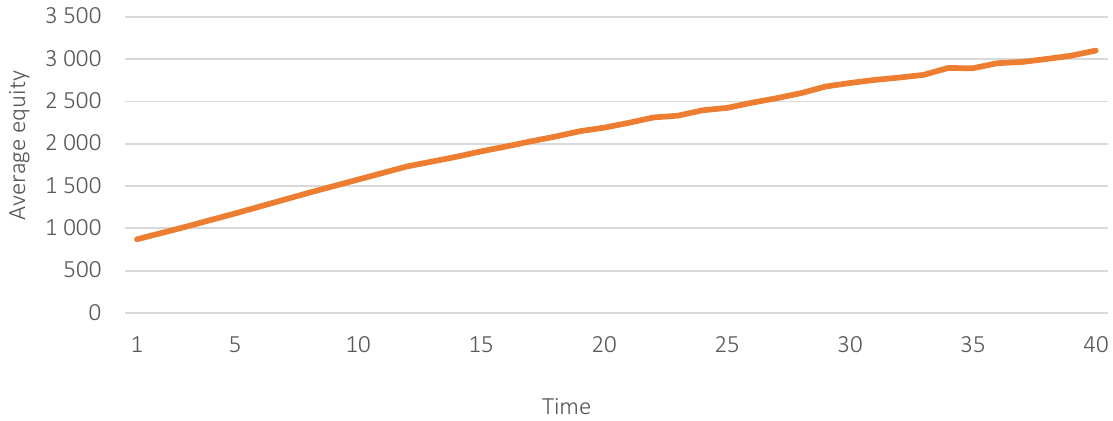
Figure 10. Evolution of average companies’ equity in a conventional LBO market